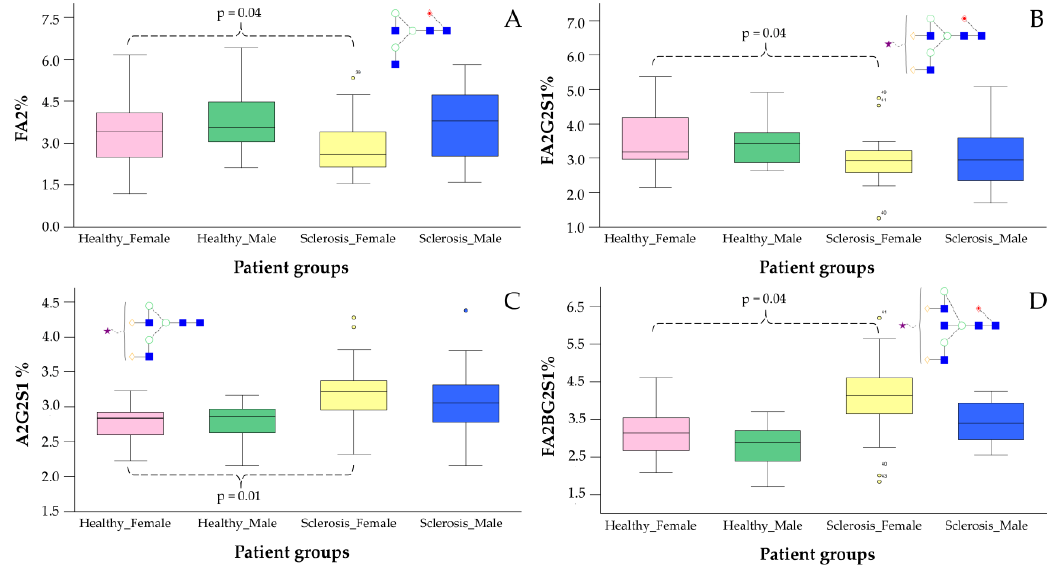
Figure 4. Significant glycosylation alterations between healthy controls and female MS patients. Similarly, the linear discriminant analysis showed a slight overlap between the male groups, while the healthy females were clearly separated from MS females based on their serum N -glycome distribution (Figure 5). The structures contributing to the separation of the patient groups were also similar to the significantly altered glycans presented in Figure 4, as FA2, A2G2S1 and FA2BG2S1 were clearly prominent. These findings are in agreement with previous studies, as altered glycosylation of plasma proteins was identified by Cvetko et al. [13]. In their study, they found significantly increased sialylation levels on the structures of A3G3S2, A3S3S3, A4G4S3, A4G4S4 and FA3G3S3 in MS patients. This is partly in agreement with our results, which also found increases in A3G3S2 and A4G4S3 (Supplementary Table S2). Moreover, A2G2S1 and FA2BG2S1 were also higher, but only in female MS patients. They also found lower FA2 levels from IgG-derived traits, which is identical to our findings, which showed that decreased FA2 was one of the main contributing factors in the separation of female MS patients. Similar to our results, a high mannose level on the Man5 structure was reported, although in our dataset, the Man6 structure was also significantly higher (Supplementary Table S2). Kennedy and colleagues also reported higher sialylation of serum-derived proteins in MS compared to healthy controls [14]. The level of galactosylation was also increased in MS, similar to our results, as A2G2 and FA2BG2 glycan ratios were higher in the disease groups, although this was only significant between the female